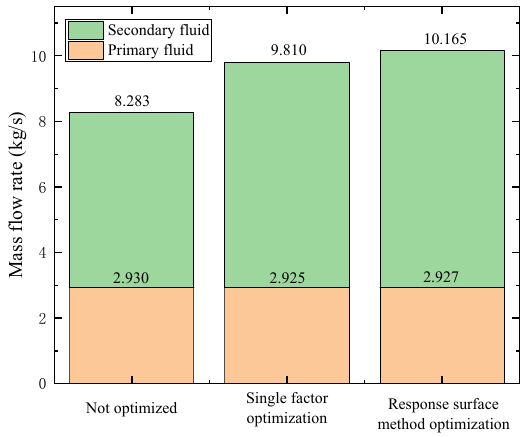
Figure 6. Fluid mass flow rate under different optimization methods.